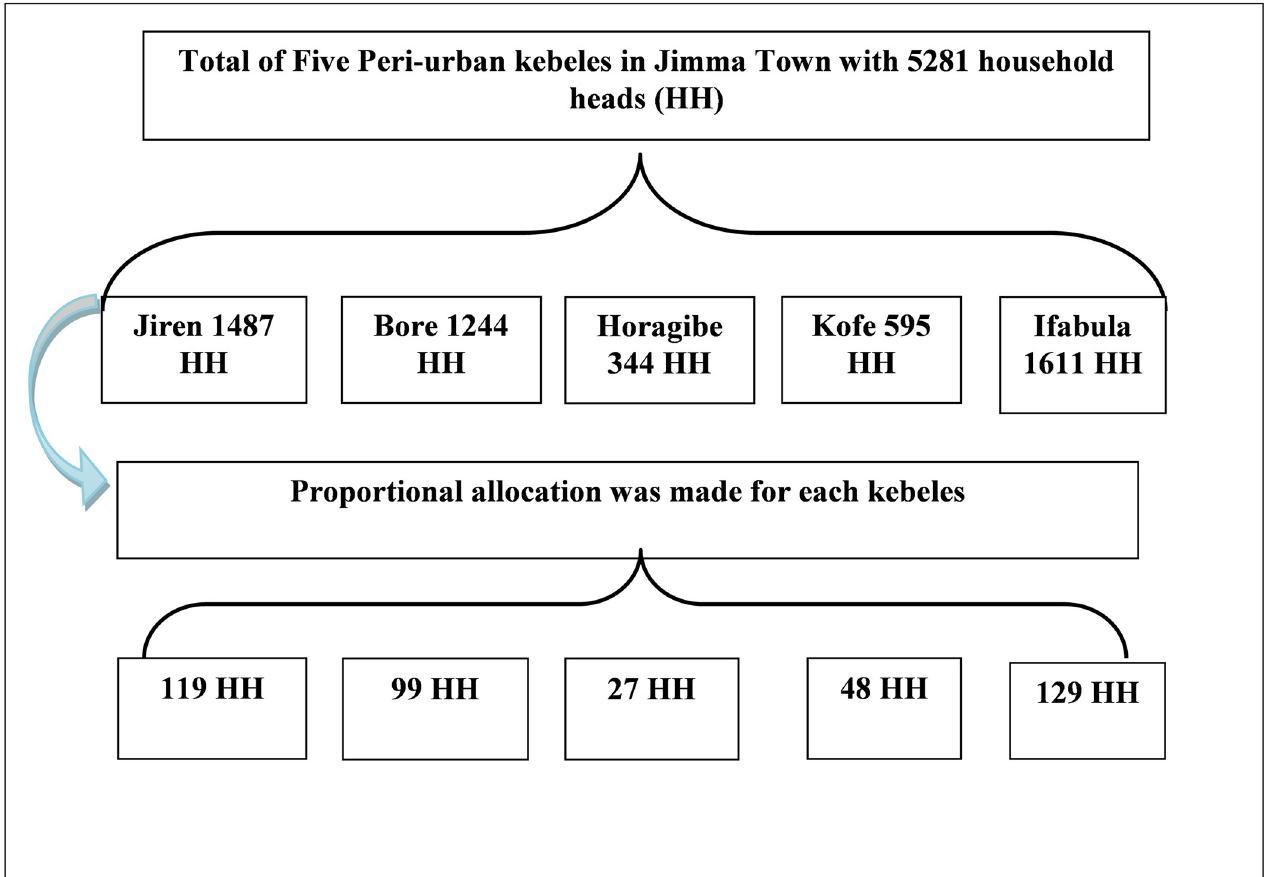
Fig 2. Diagrammatic representation of the study kebeles (area) and their respective household heads (HH).